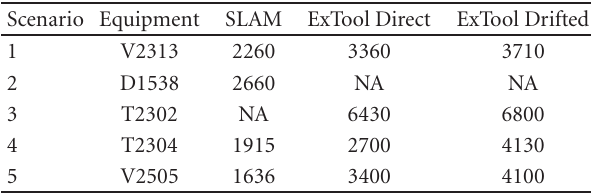
Table 2: Summary of property damage (million